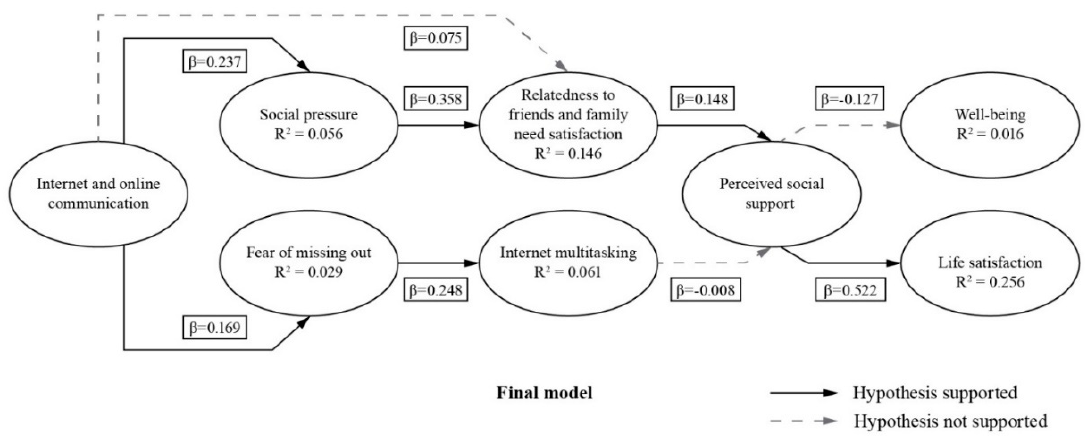
Figure 2. Hypotheses (supported and not supported).